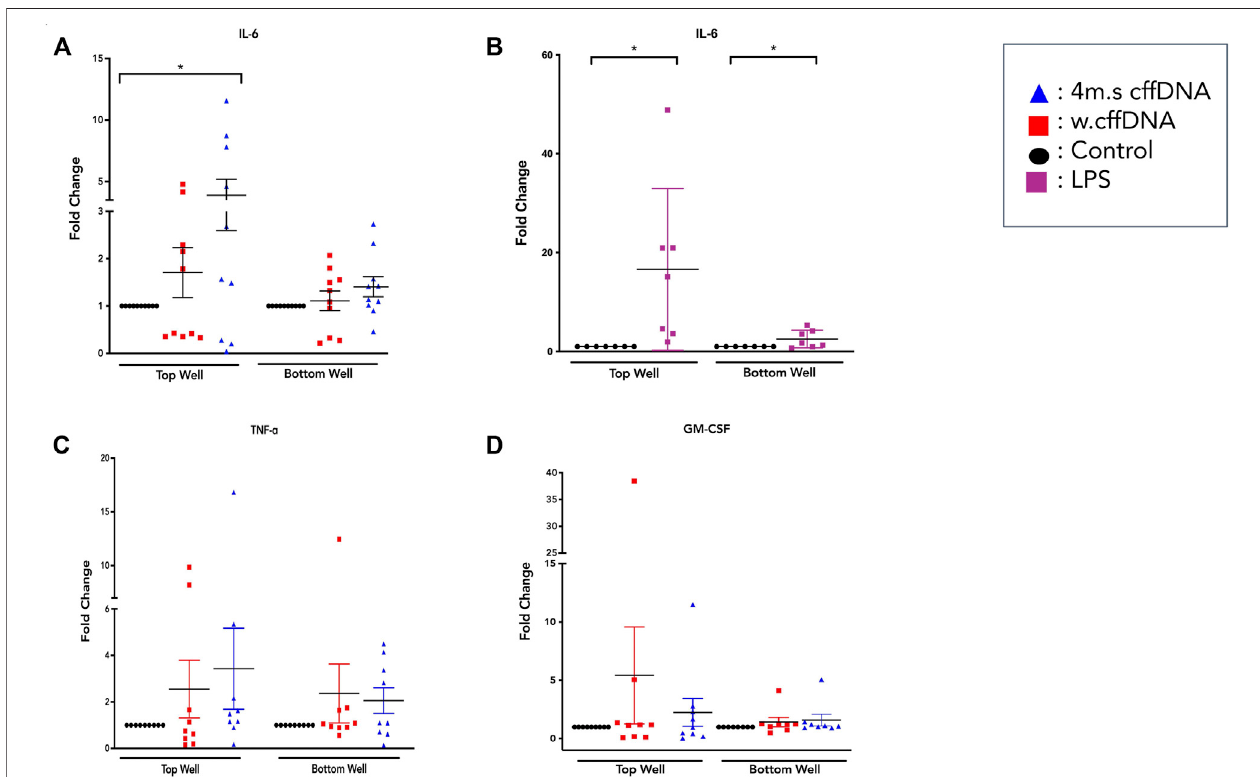
FIGURE 3 | Cytokine secretion from fetal membrane explants after treatment with w.cffDNA or 4 m.s cffDNA. Fold change secretion, compared to no treatment control, of cytokines into the apical (top) well or basal (bottom) well of the transwell fetal membrane explant after treatment with (red) w.cffDNA or (blue) 4 m.s. cffDNA at 100 ng/m. (A) IL-6, (B) IL-6 after treatment with LPS (100 ng/ml), (C) TNF- ɑ , and (D) GM-CSF. n = 7 – 10 patients. * p = < 0.05.